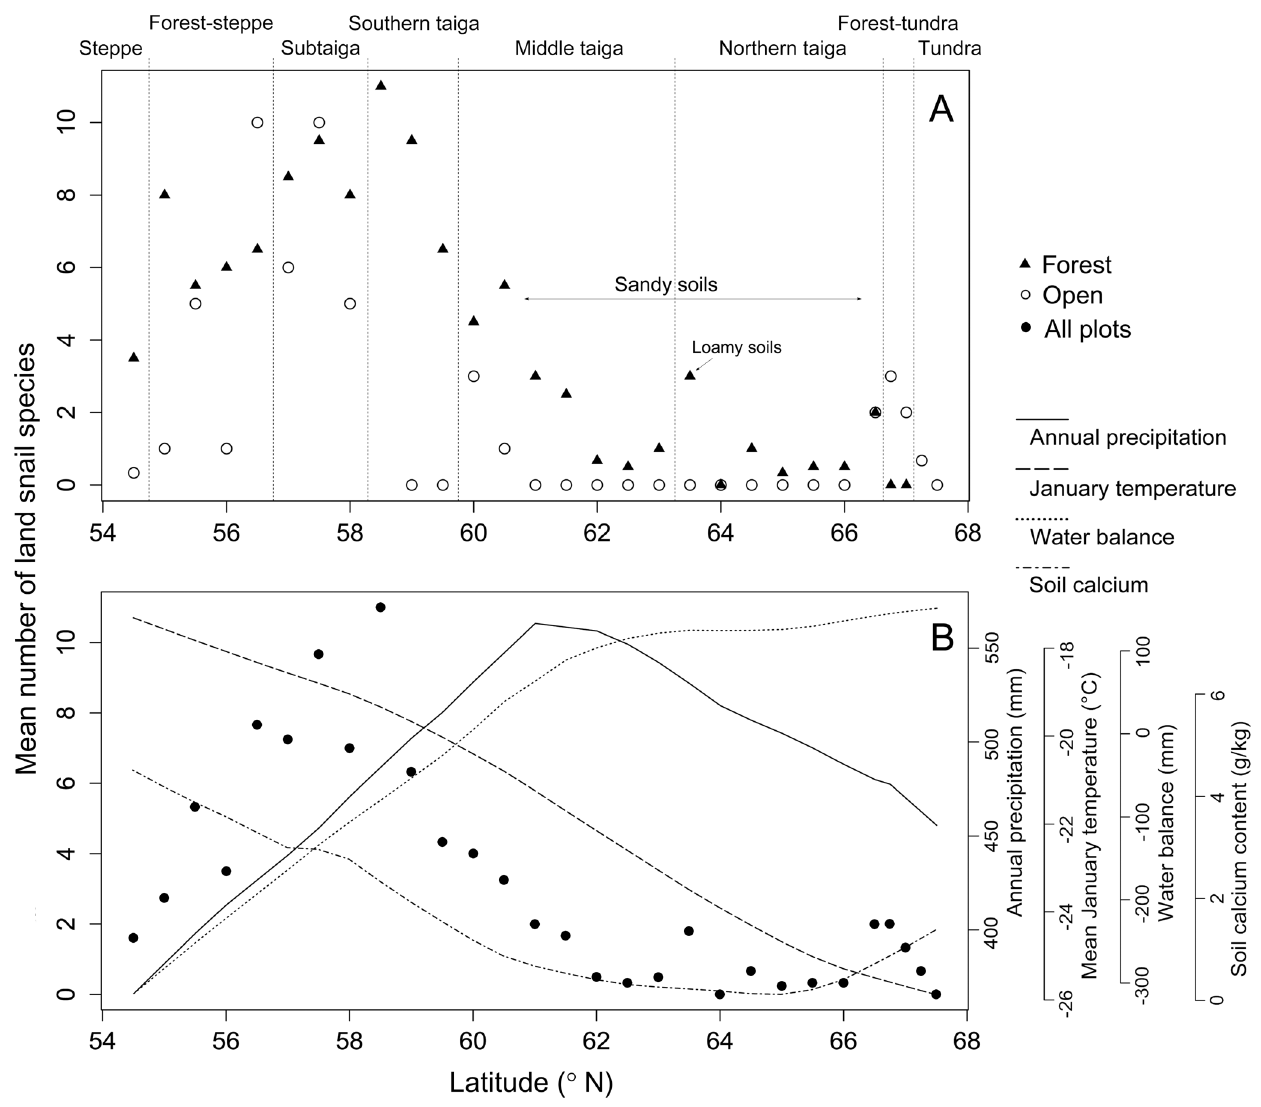
Figure 2. Mean numbers of land snail species recorded in 100 m 2 plots at 29 sites located along a latitudinal transect in the West Siberian Plain between 54.5 6 and 67.5 6 N. A , species from forest and open habitats counted separately; B , means from all plots at each site shown with patterns of four environmental variables visualized using the locally-weighted polynomial regression.